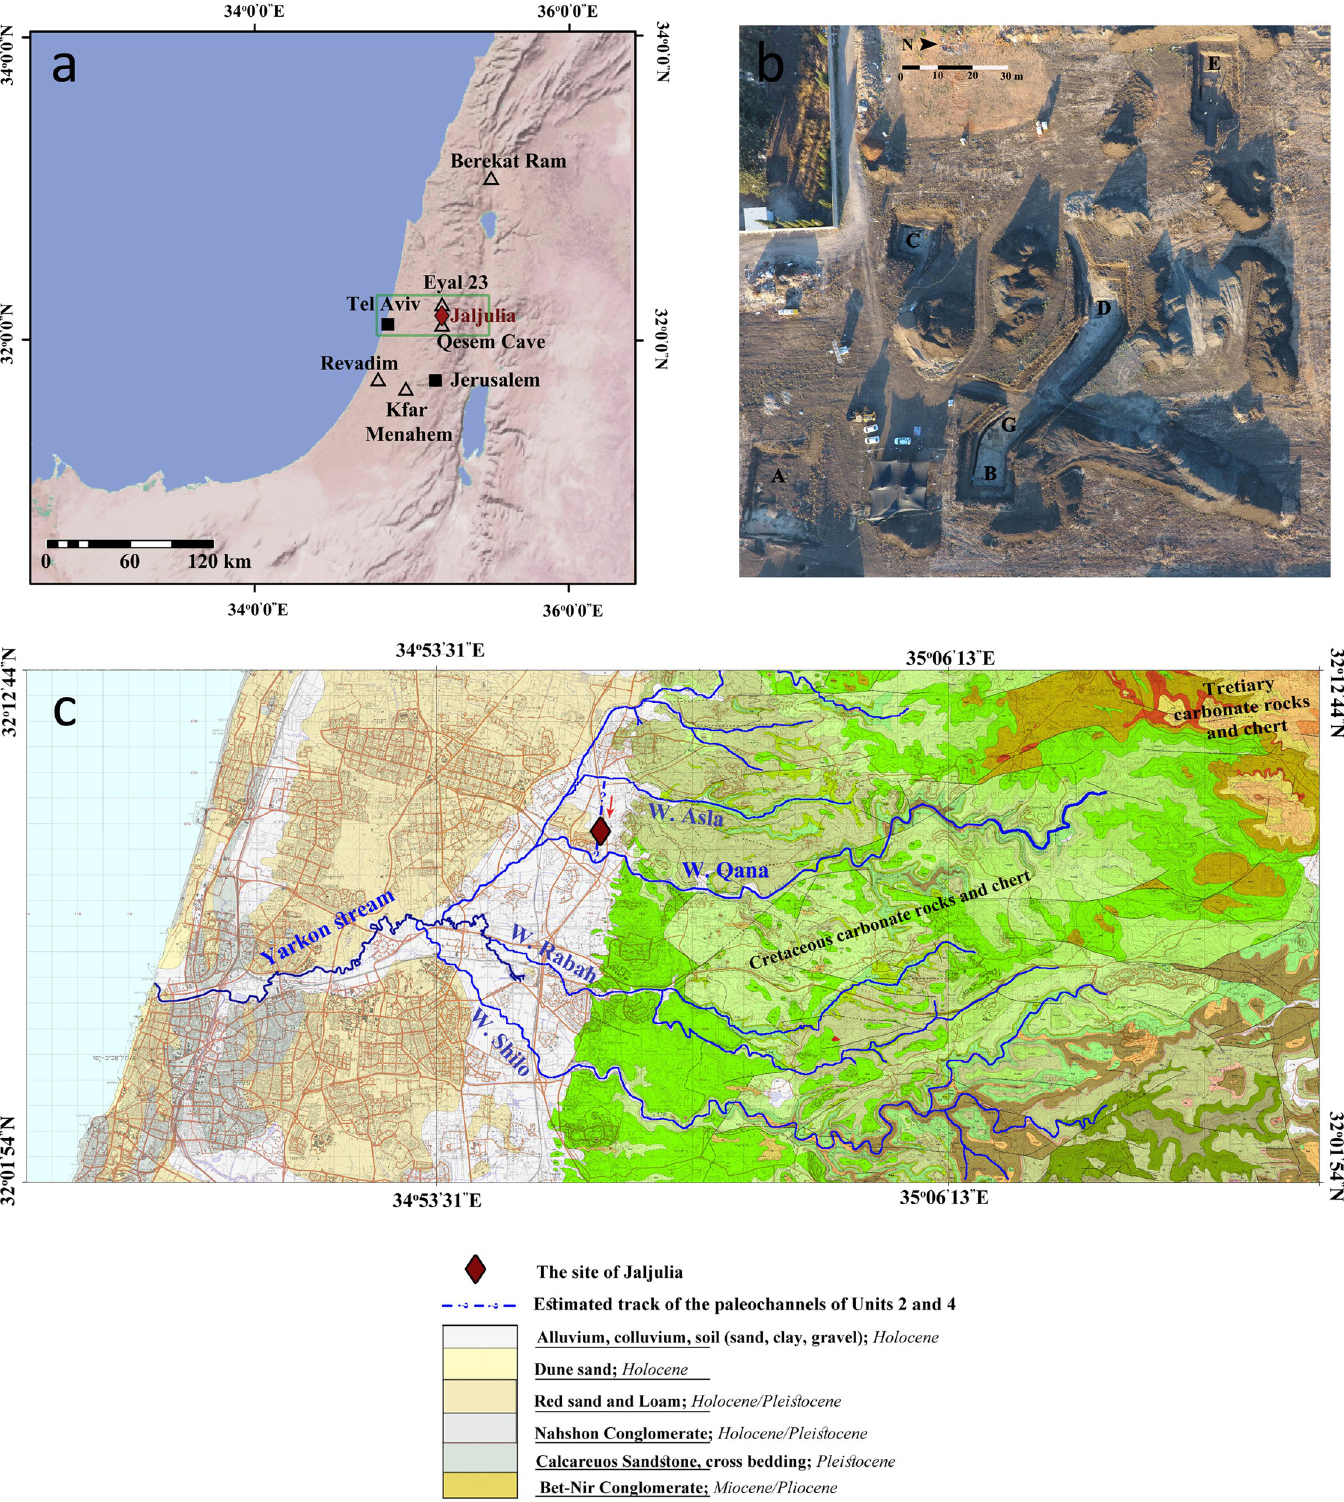
Fig 1. Location and geological setting of the site of Jaljulia. a) Location of the site of Jaljulia and main sites mentioned in this paper (base-map source: US National Park Service). Green frame marks the area presented in Fig 1c; b) Geographic distribution of the excavated localities in Jaljulia; c) Geological setting of the site of Jaljulia, with marks of the main streams associated with the formation processes of the site (base-maps provided by the Geological Survey of Israel, created by [58–60]).